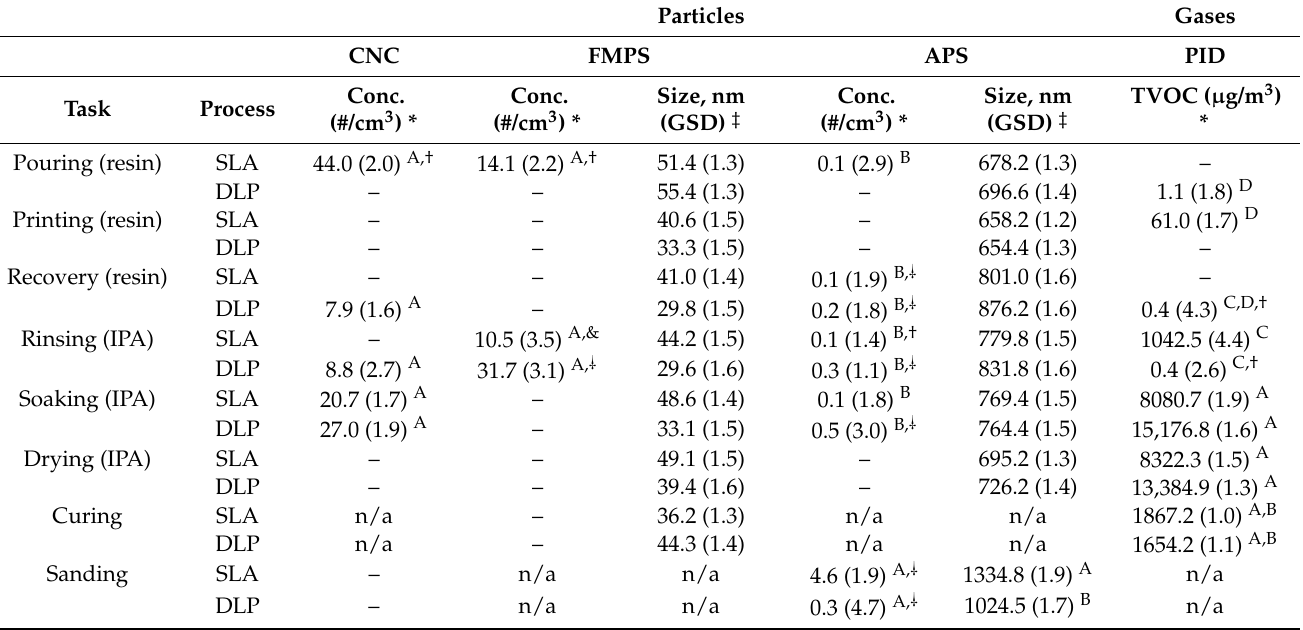
Table 2. Geometric mean (geometric standard deviation) average background-corrected airborne particle and total volatile organic compound (TVOC) concentrations and particle sizes by process and task (n = 5 replicates) 1 .